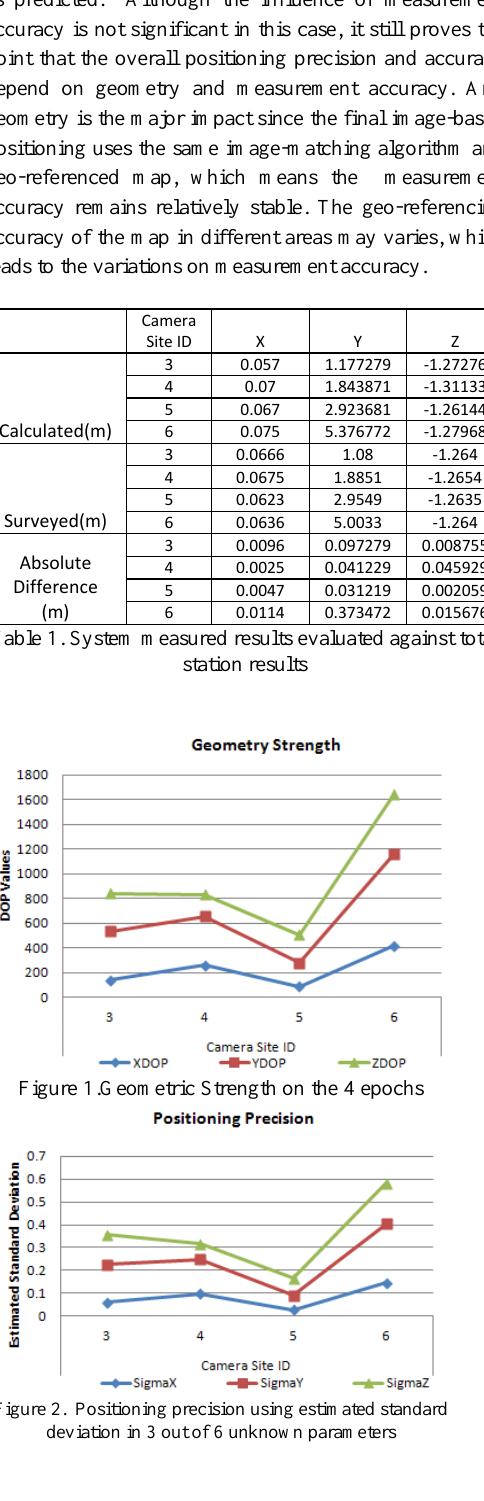
Figure 2. Positioning precision using estimated standard deviation in 3 out of 6 unknown